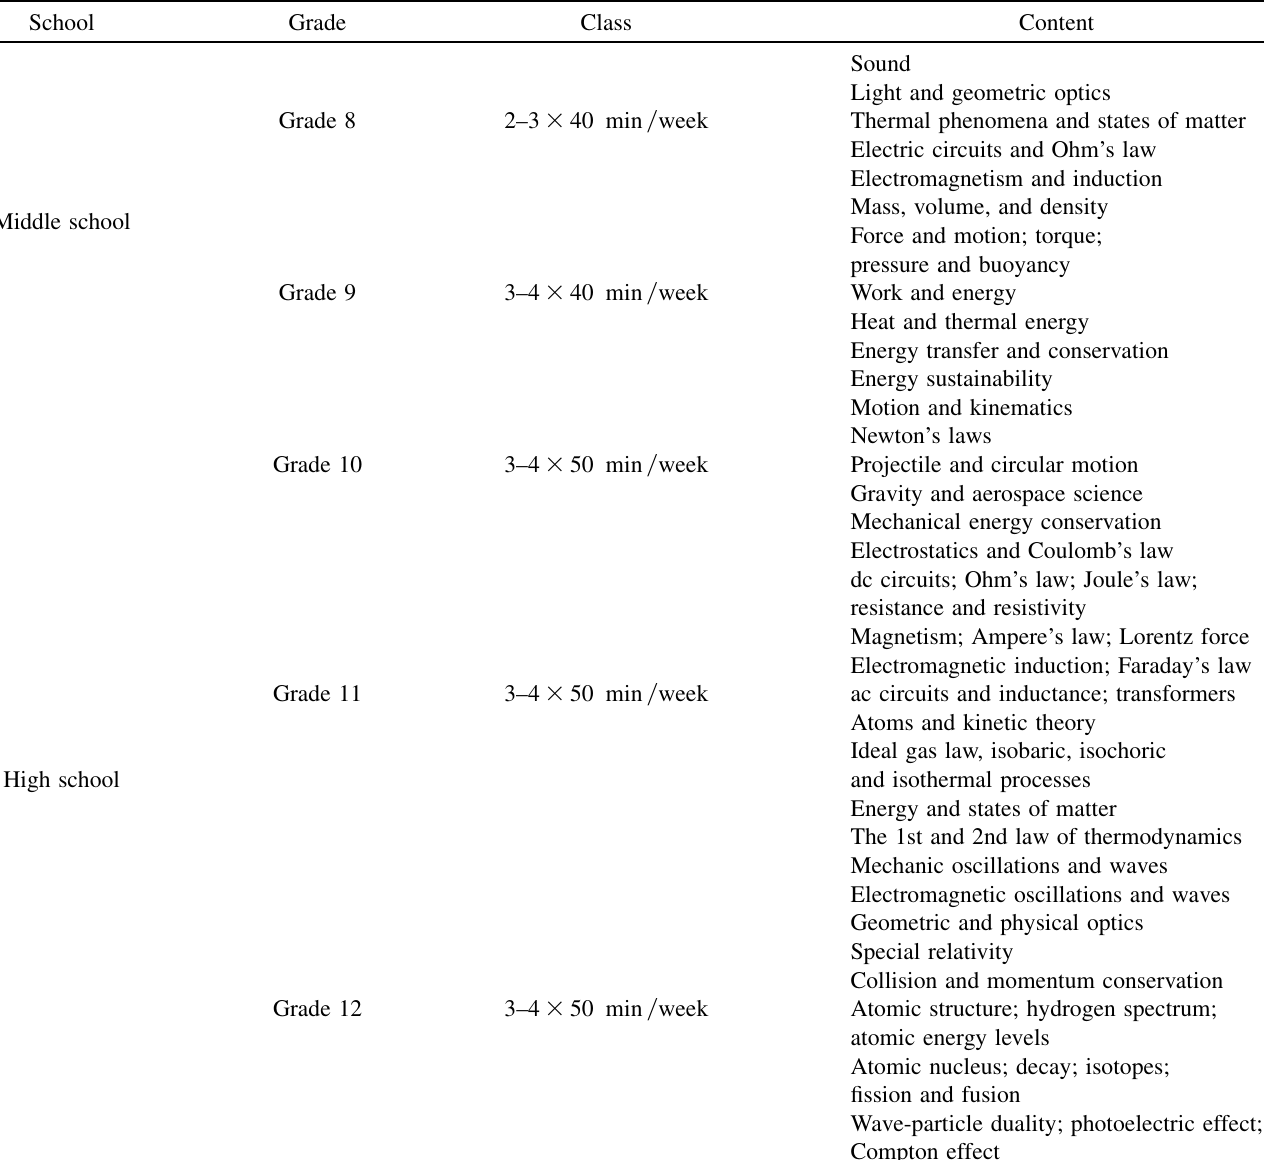
TABLE I. Content and sequence of Chinese middle and high school